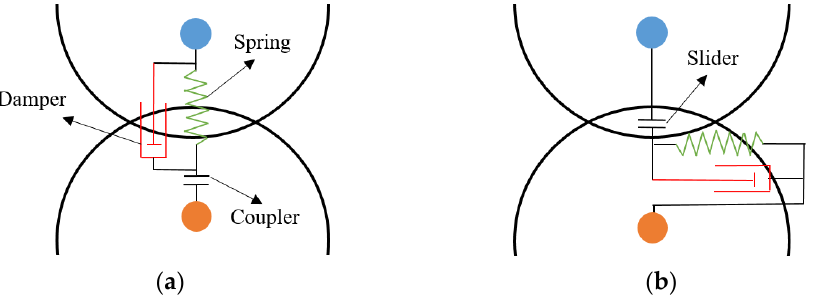
Figure 1. Simplification of the contact force between particles by Hertz–Mindlin soft sphere model: ( a ) normal force; and ( b ) tangential force.